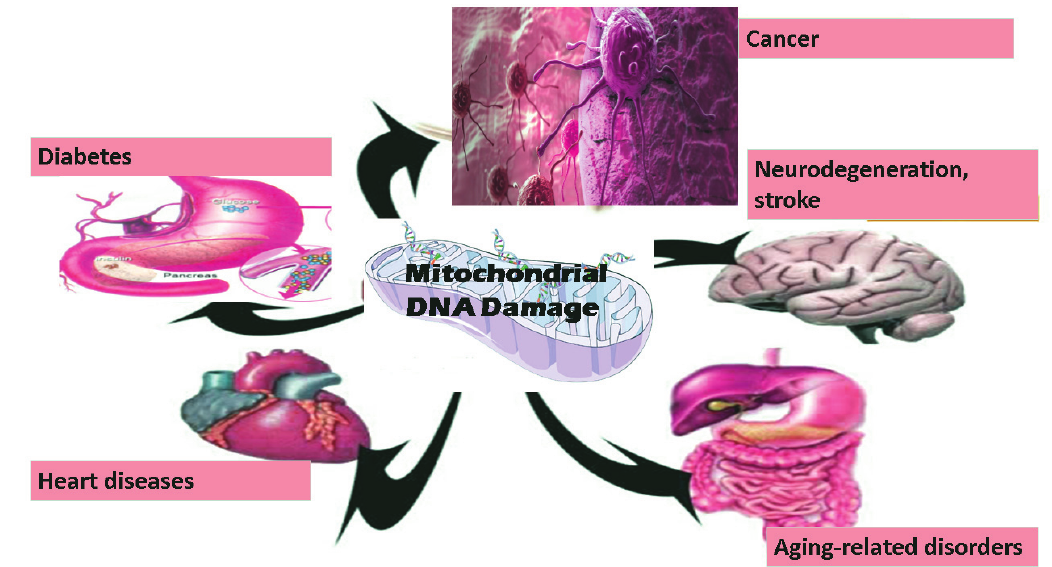
Figure 1. Mitochondrial DNA damage is associated with various